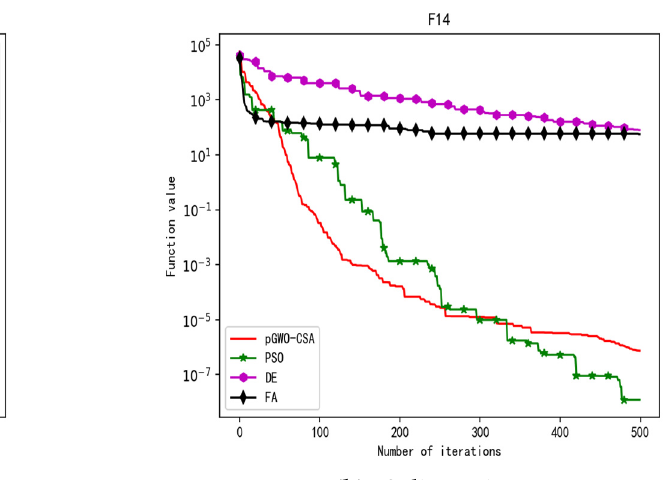
Figure 18. Convergence curve of test function F14.